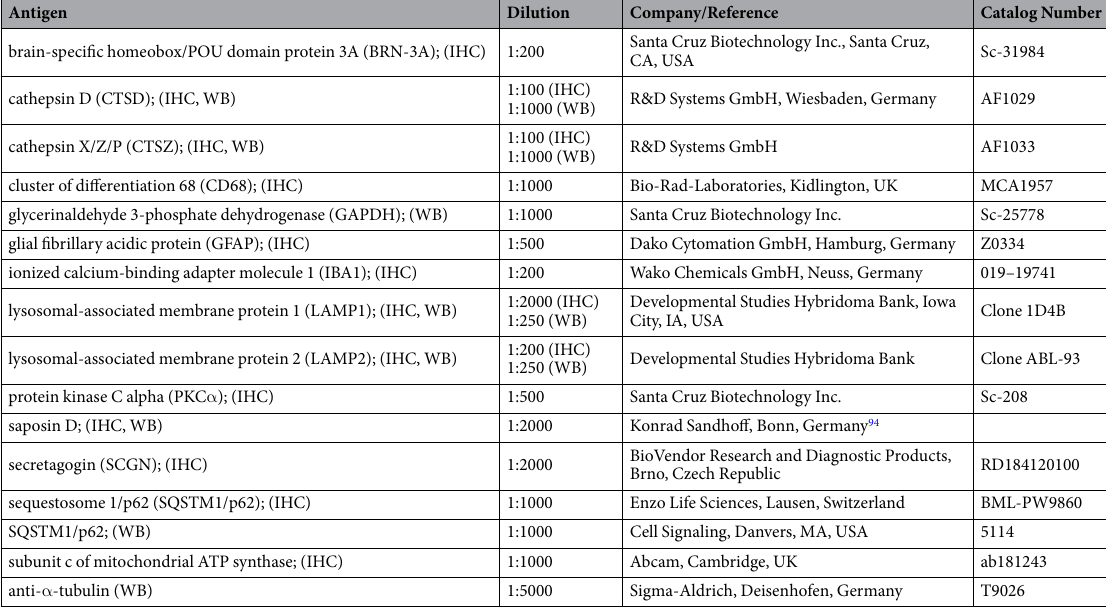
Table 1. Primary antibodies. IHC: immunohistochemistry, WB: Western